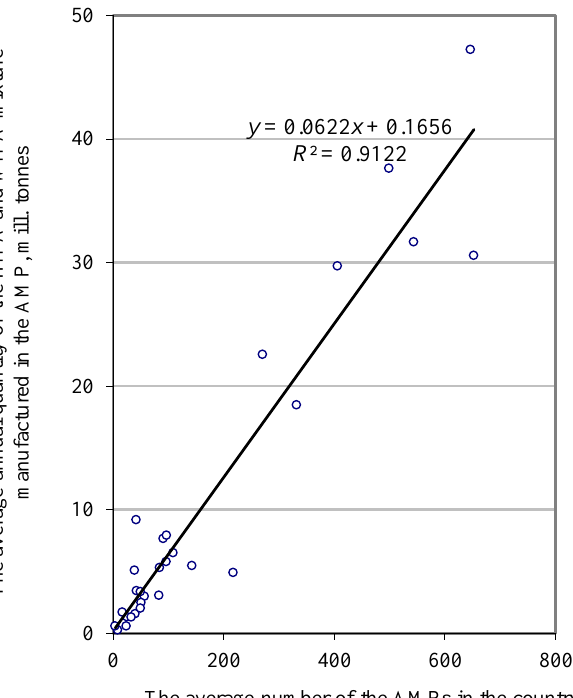
Figure 4. The correlation between the number of AMPs operating in 30 European counties ( N c ) and the amount of the asphalt mixture produced in the AMPs ( P c ).